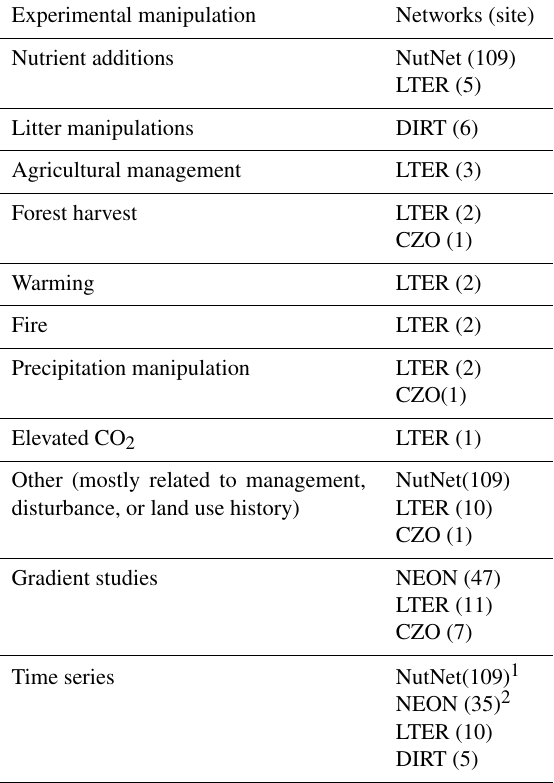
1 Repeated measurements for NutNet are for plant productivity, not soil measurements. 2 Not all NEON sites have been sampled more than once per